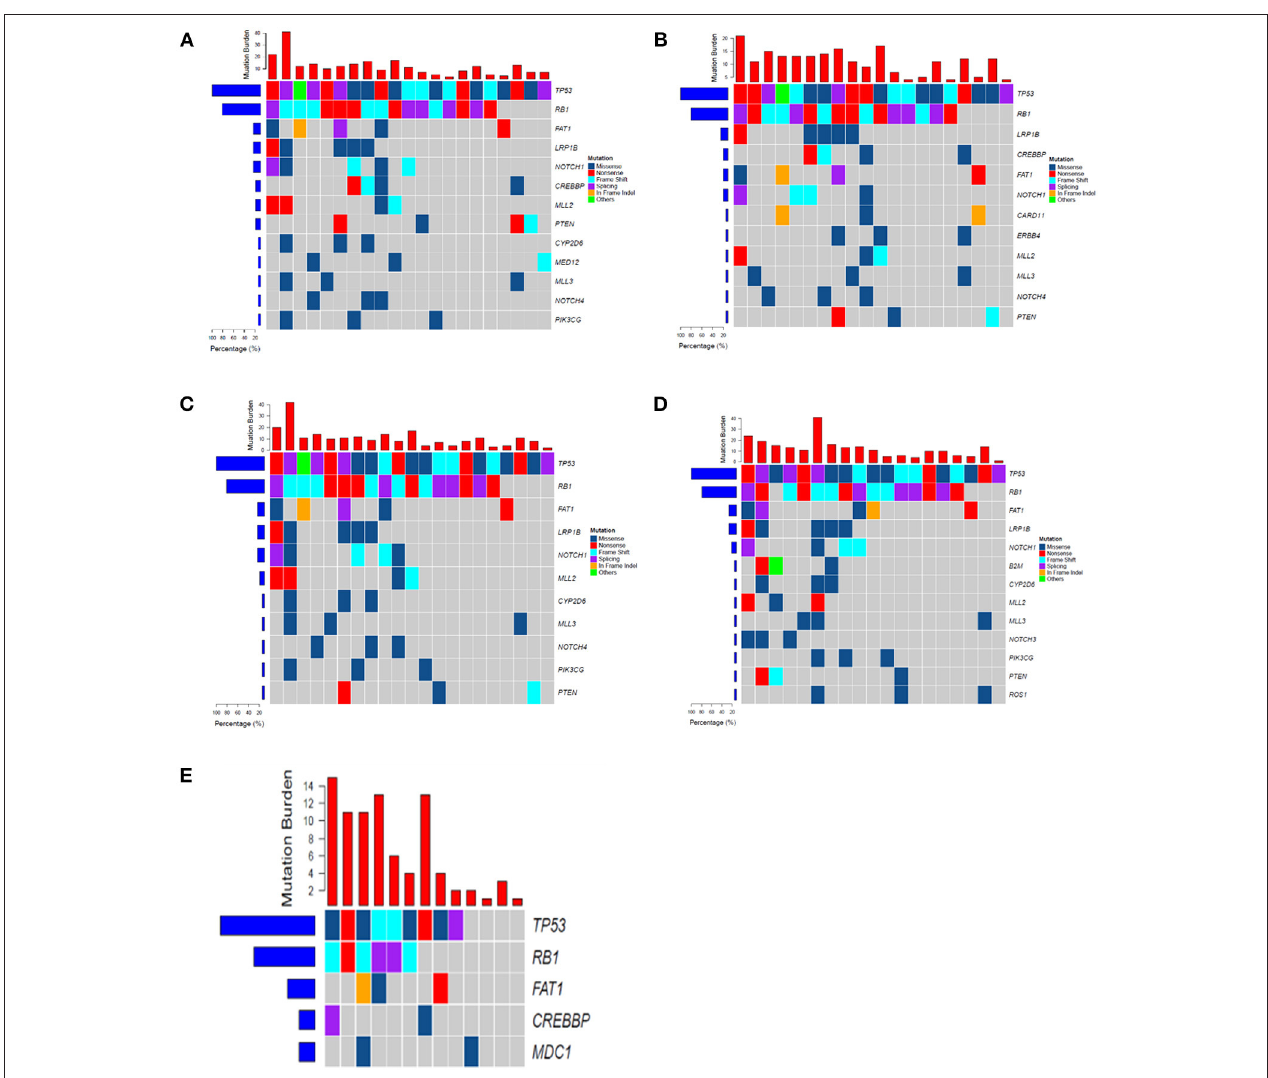
FIGURE 2 | The frequency spectrum for all patients with detectable mutations. (A) Mutation frequency spectrum in tumor tissue (only showed genes existing in more than three samples). (B) Mutation frequency spectrum in BWFs (only showed genes existing in more than three samples). (C) Mutation frequency spectrum in BWFp (only showed genes existing in more than three samples). (D) Mutation frequency spectrum in pre-treatment plasma (one sample was not detected; only showed genes existing in more than three samples). (E) Mutation frequency spectrum in post-treatment plasma (only showed genes existing in more than two